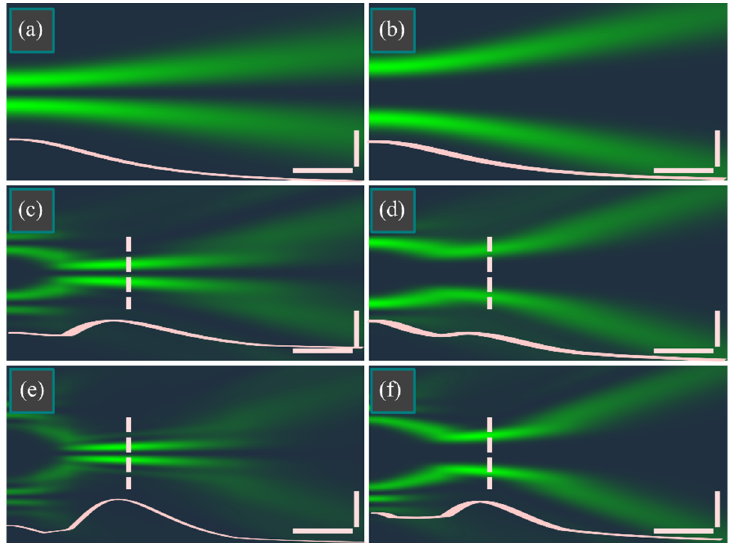
Figure 3. Longitudinal intensity distributions of the beam from Equation (1) with the topological charge of 1 ( a , c , e ) and 4 ( b , d , f ) when the radial (lower) index n of the associated Laguerre polynomial is as 0 ( a , b ), 3 ( c , d ), 6 ( e , f ). Below each distribution, a longitudinal intensity cross-section is shown. Horizontal and vertical scale marks denote, respectively, z 0 /2 and 1 mm. Transverse dashed line denotes the autofocus plane z = z 0 .